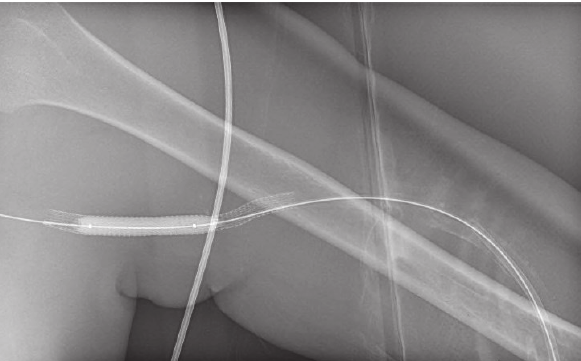
Fig. 2. Stent graft implantation into the VAG.